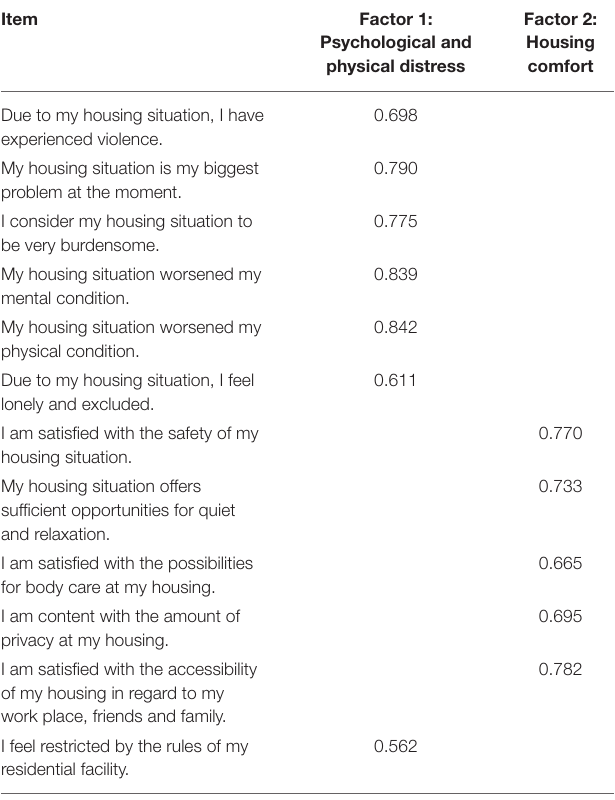
TABLE 2 | Factor loadings of the subjective screening items on examined housing satisfaction domains.